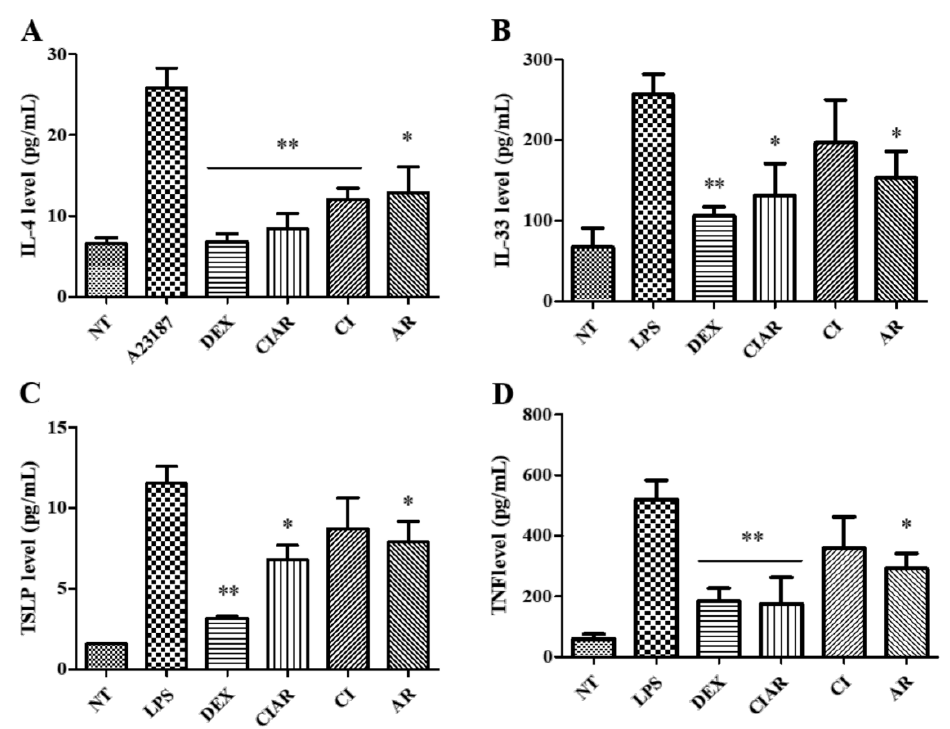
Figure 5. Effects of CI, AR, and CIAR in LPS-induced RAW264.7 cells or A23187-induced RBL-2H3 cells. ( A ) Reduced cytokine IL-4 levels in RBL-2H3 cells. ( B – D ) show reduced cytokine levels in LPS-induced RAW264.7 cells. Data are shown as the mean ± SE. Significant differences are indicated as ** p < 0.01 and * p < 0.05, compared to the LPS group. NT—normal cell; LPS—LPS-treated group (1 μg/mL); A23187—A23187-treated group (1 μM); DEX—dexamethasone-treated group (100 mg/mL); Table 2. Contents of organic acids in CI and AR.